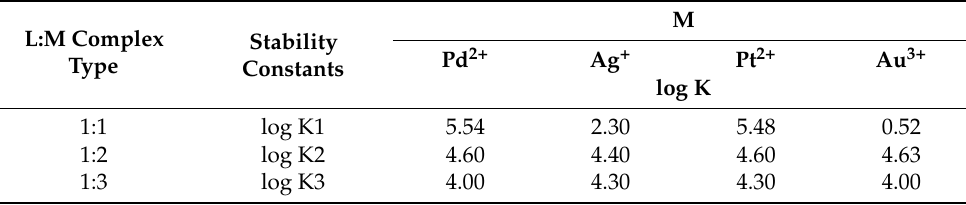
Table 2. The stability constants of the complexes of salen (L) with Pd 2+ , Ag + , Pt 2+ , and Au 3+ ions. L:M Complex Type